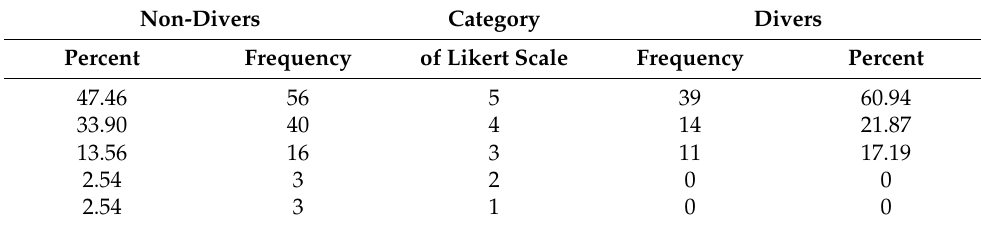
Table 5. Scuba diving impact on the improvement of social interactions.